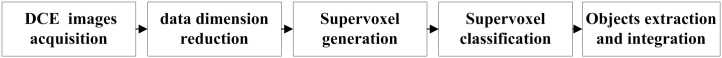
Flow chart of the image segmentation scheme.The proposed segmentation algorithm includes five consecutive steps: DCE micro-CT images acquisition, data dimension reduction, supervoxel generation, supervoxel classification, and target organs’ extraction.